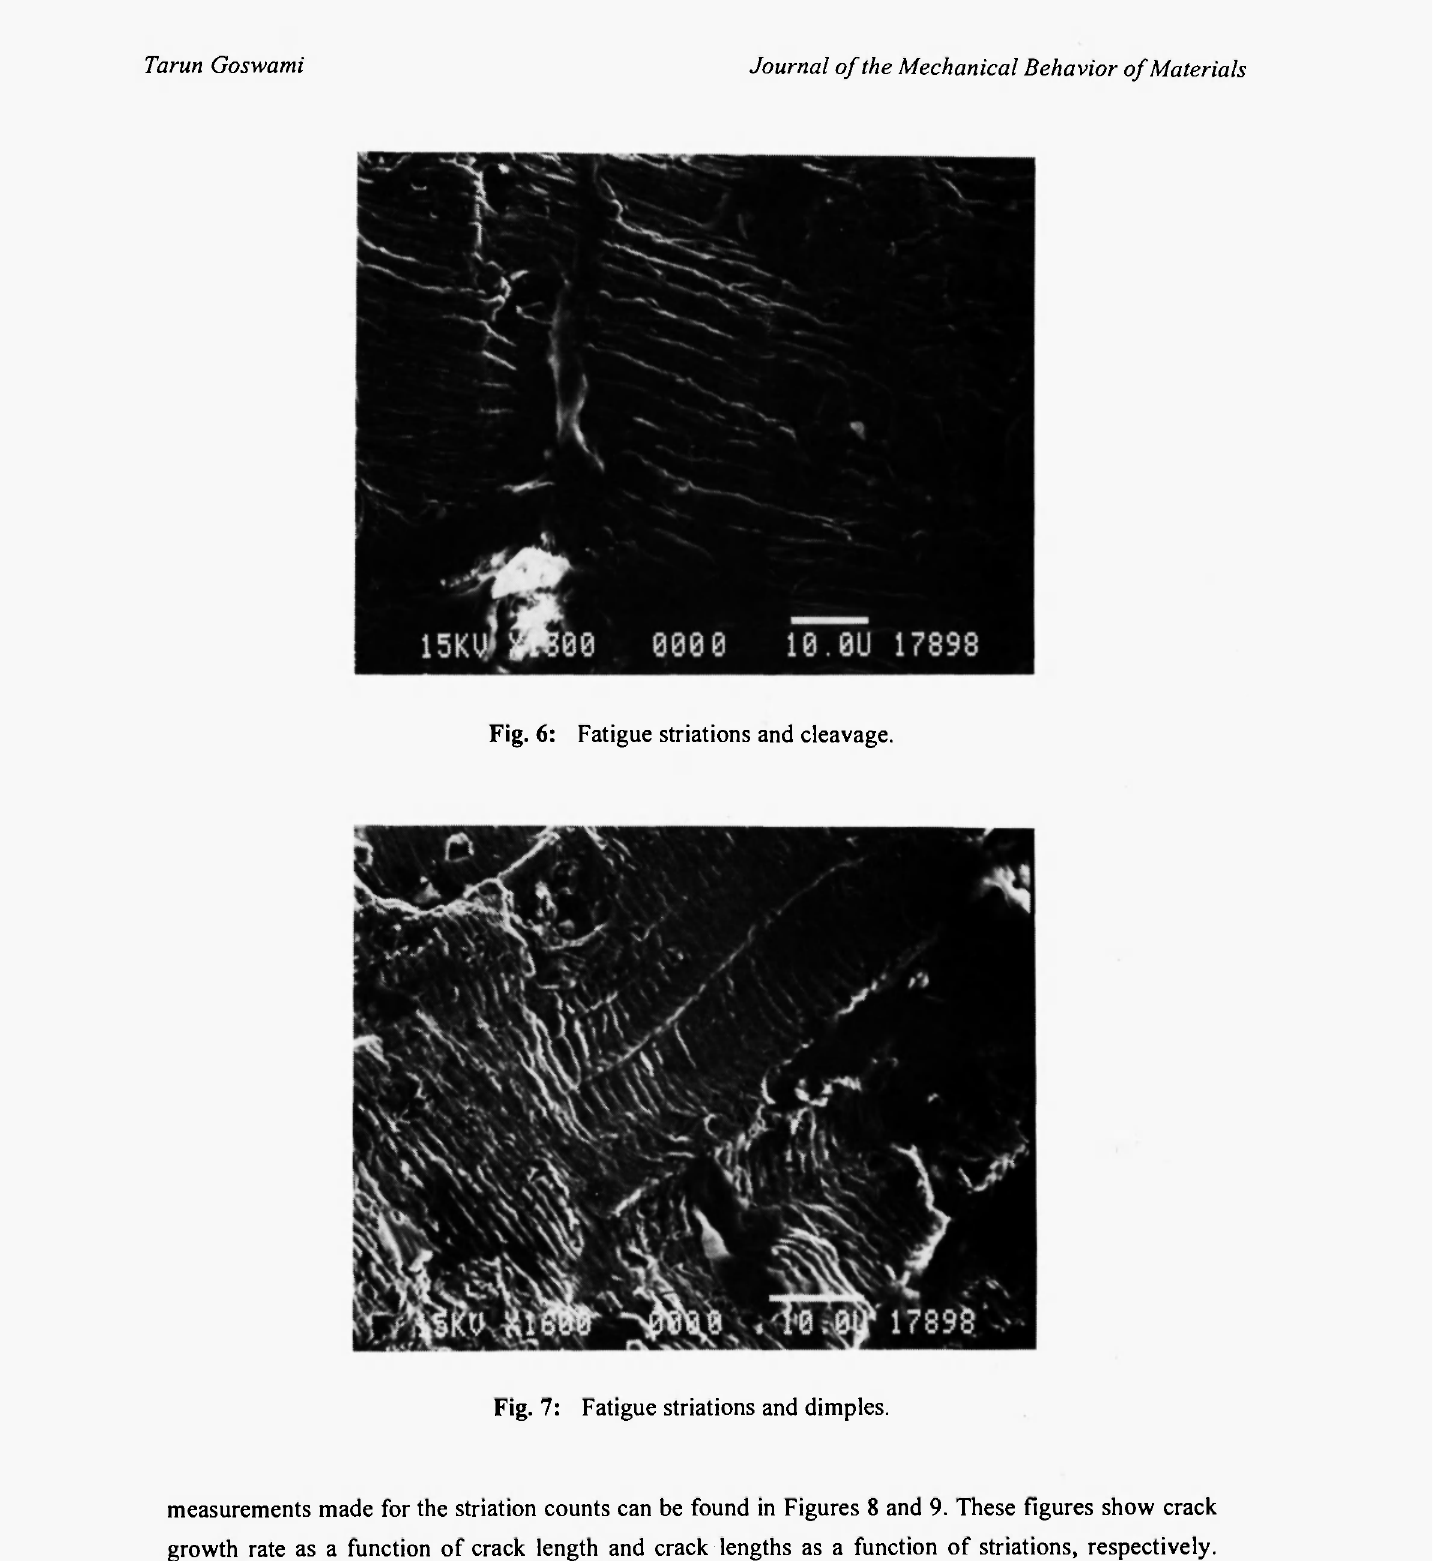
Fig. 7: Fatigue striations and